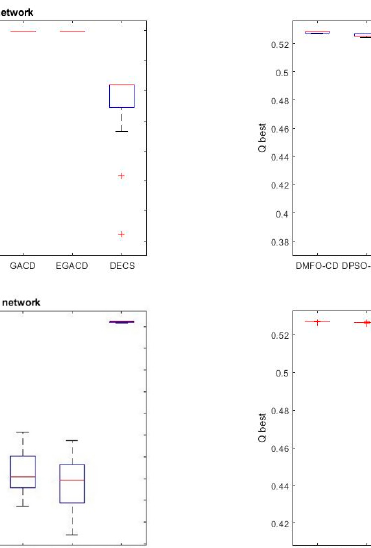
Table 2 and Figure 10 show the obtained modularity by DMFO-CD and comparative algorithms on eleven datasets. As per the results in Table 2 and Figure 10, DMFO-CD, GACD, and EGACD have the highest value of modularity and lowest distribution of modularity on karate network. In Figure 10, EGACD has the largest distribution of modularity than others, and GACD has the lowest average modularity that shows that they have the poorest performance on the dolphins network. The average modularity gained by GA-Net is better than EGACD and GACD; however, its distribution is near to GACD. The modularity of DMFO-CD is evident in that it is superior to other comparative algorithms for detecting communities of the dolphins network. As shown in Figure 10, GACD and EGACD have the lowest performance in the football dataset among other algorithms, while DMFO-CD and DPSO-PDM have better results than other algorithms. Figure 10 shows the results on polbooks network in which the GA-NET algorithm has the largest distribution and weak modularity, while in comparison to other algorithms, DMFO-CD has the best average modularity. Table 2 shows that DMFO-CD has mostly gained the best result of modularity among other comparative algorithms on webkb datasets. GACD and EGACD have the results near to DMFO-CD, and DPSO-PDM could not gain proper results in term of modularity. For adjnoun dataset, as shown in Figure 10, the proposed DMFO-CD has the best average of modularity than other comparative algorithms. GACD and EGACD after DMFO-CD have better results than DPSO-PDM, GA-Net, and DECS. In Table 2 the row of email-Eu represents the results of modularity on email-Eu dataset that DMFO-CD has the best results on it. DMFO-CD in compare with GA-Net and DECS has better performance and is near to EGACD. As shown in Figure 10, the performance of DMFO-CD in terms of modularity for dblp dataset is better than others, except for DPSO-PDM.